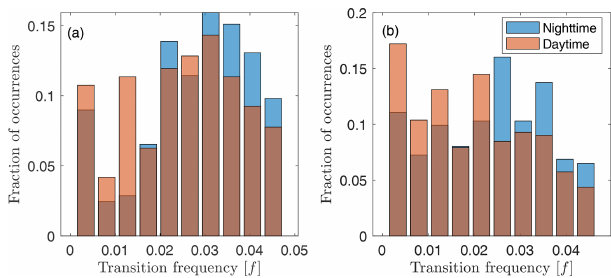
Figure 3. Transition frequency distributions for the WC49 (a) and WC68 (b) lidars during nighttime and daytime